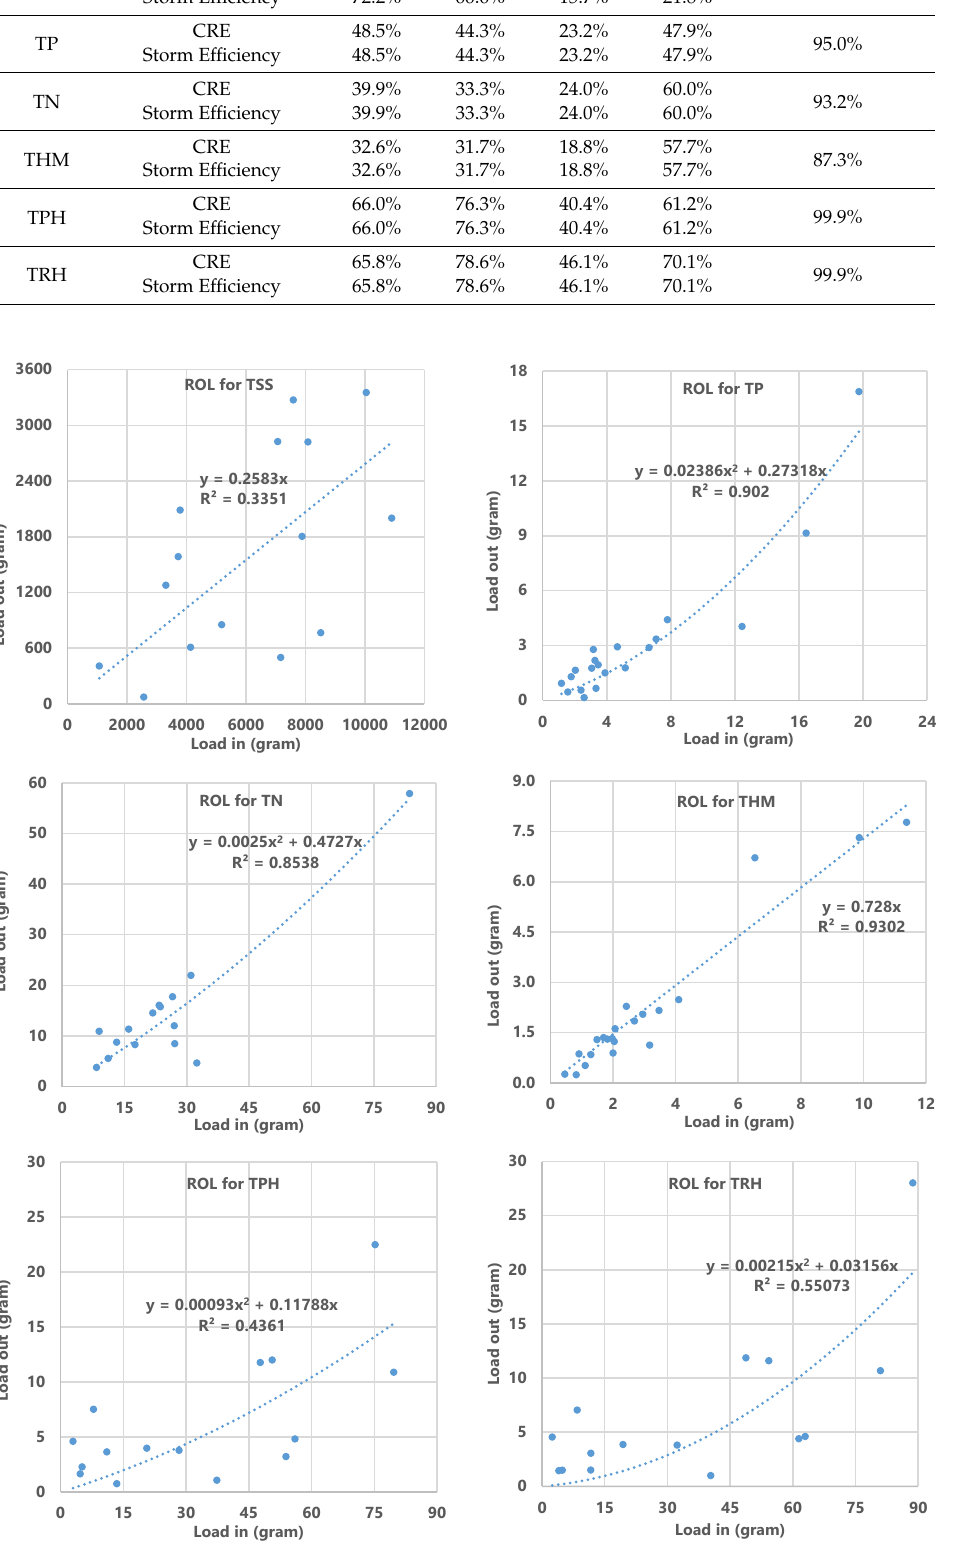
Figure 9. Regression fitting curves for pollutant loads (ROL).